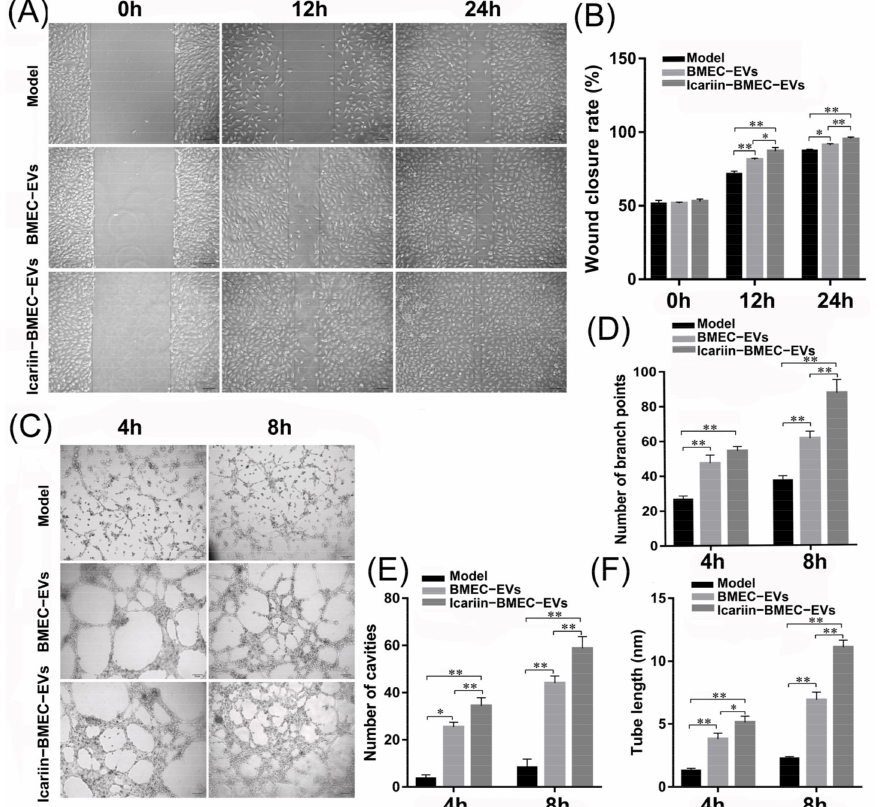
Figure 7. Effect of EVs on endothelial cell migration and angiogenesis. ( A ) Observation of scratch assay at 0, 12, and 24 h after hydrocortisone treatment; ( B ) scratch closure rate in three groups; ( C ) tube formation assay at 4 h and 8 h after hydrocortisone treatment; ( D – F ) number of branch points, number of cavities and tube length at 4 h and 8 h after hydrocortisone treatment. Data analysis was performed by t -test and ANOVA, with error bars indicating SD, ** indicating p < 0.01, and * indicating p < 0.05. Control indicates BMEC that were not co-cultured with EVs but treated with hydrocortisone; BMEC-EVs represent BMEC that were co-cultured with EVs secreted by BMECs without icariin intervention; and Icariin-BMEC-EVs indicate BMEC that were co-cultured with EVs secreted by BMECs treated with icariin and then treated with